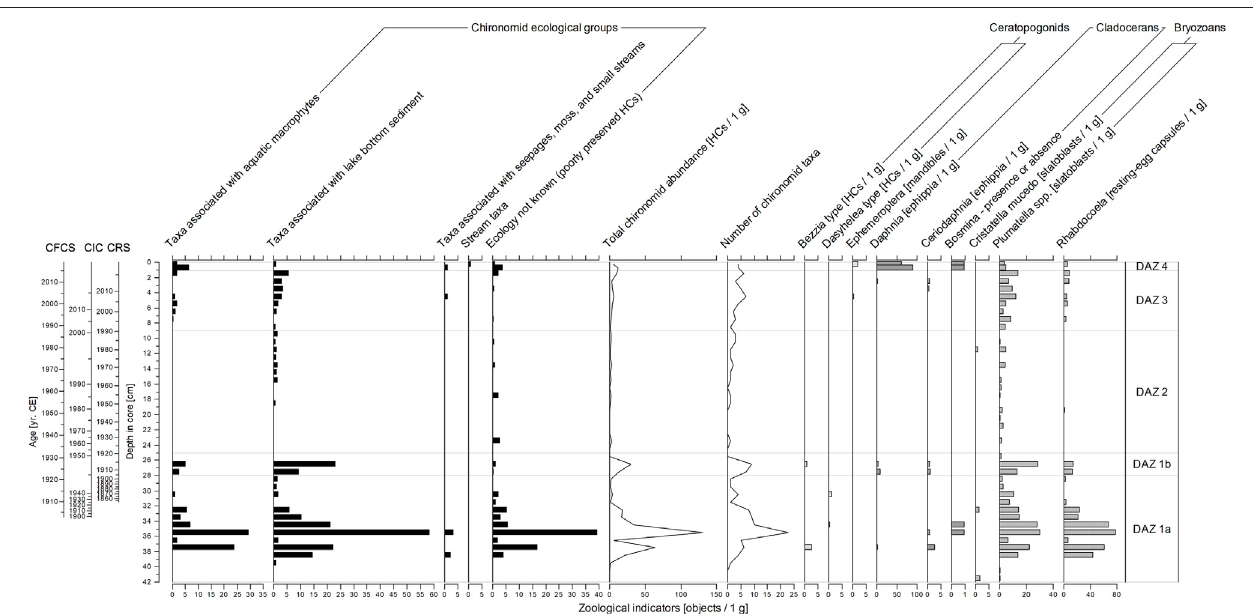
FIGURE 5 | Summary freshwater invertebrate stratigraphy diagram (core SUZ1). For information about taxa included into particular chironomid ecological groups see the Supplementary Material ( Supplementary Figure S8 ).